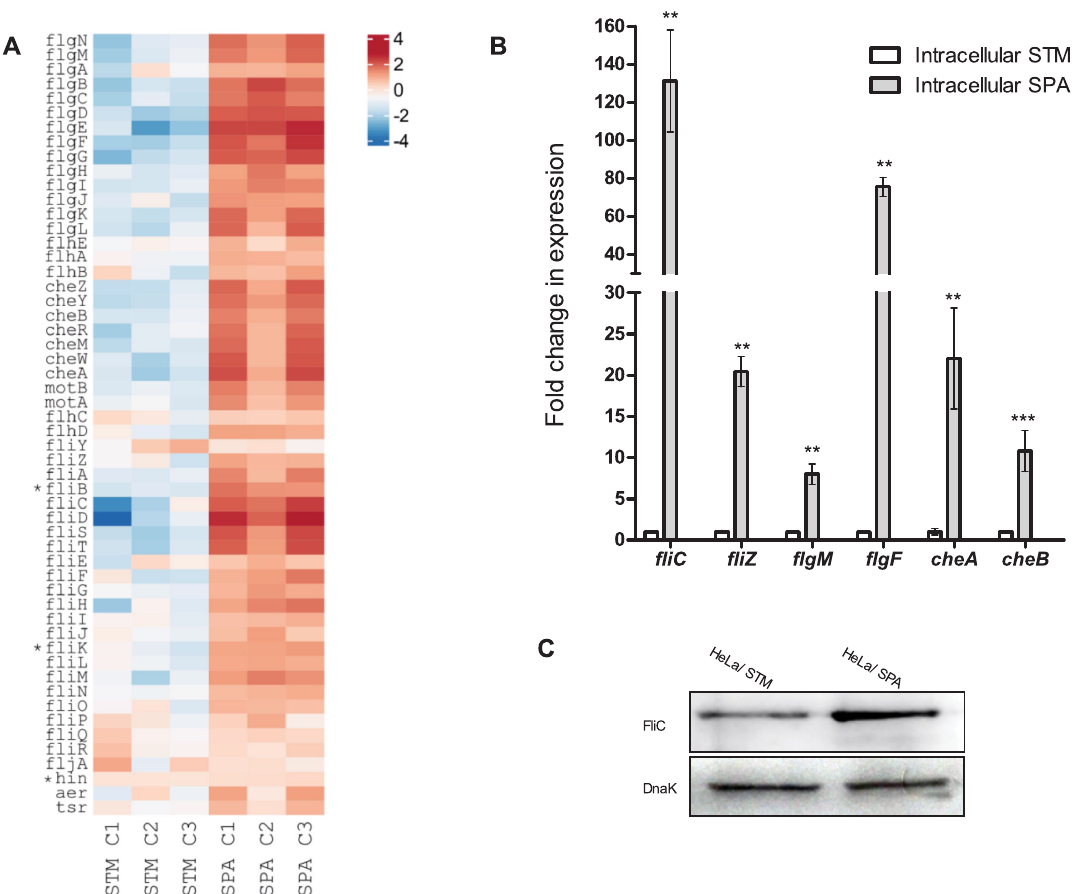
Fig 6. Intracellular SPA expresses higher levels of motility-chemotaxis genes than intracellular STM. ( A ) Heat map of RNA-Seq results showing the relative transcription of the motility-chemotaxis regulon in three independent HeLa cells infections with STM and SPA. ( B ) The fold change in the transcription of six flagellum genes ( fliC , fliZ , glgM , flgF , cheA and cheB ) in intracellular SPA relative to their expression in intracellular STM was analyzed by qRT-PCR. RNA was extracted from FACS-sorted intracellular salmonellae 8 h p.i. The results show the mean of 3–5 independent reactions and the error bars indicate the SEM. ( C ) SPA and STM strains expressing GFP were used to infect HeLa cells. At 8 h p.i., cells were fixed and FACS-sorted. Equal numbers of 1 × 10 6 infected HeLa cells were collected, lysed, and proteins were separated on 12% SDS-PAGE. Western blotting using anti-FliC antibodies were used to detect synthesis of FliC by intracellular Salmonella . Anti-DnaK antibodies were used as a loading